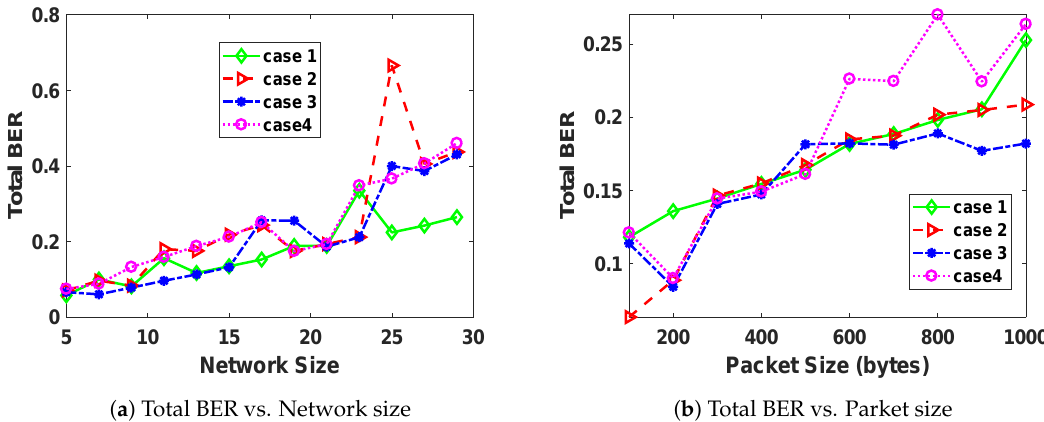
Figure 6. The effect of increasing network size and packet size, on the total Bit Error Rate (BER) of the